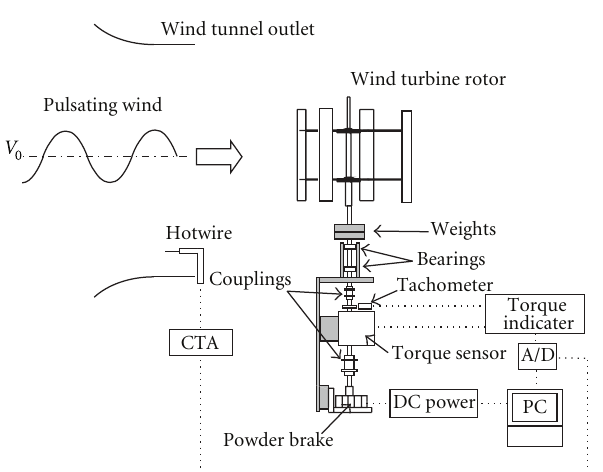
Figure 1: Experimental VAWT setup.